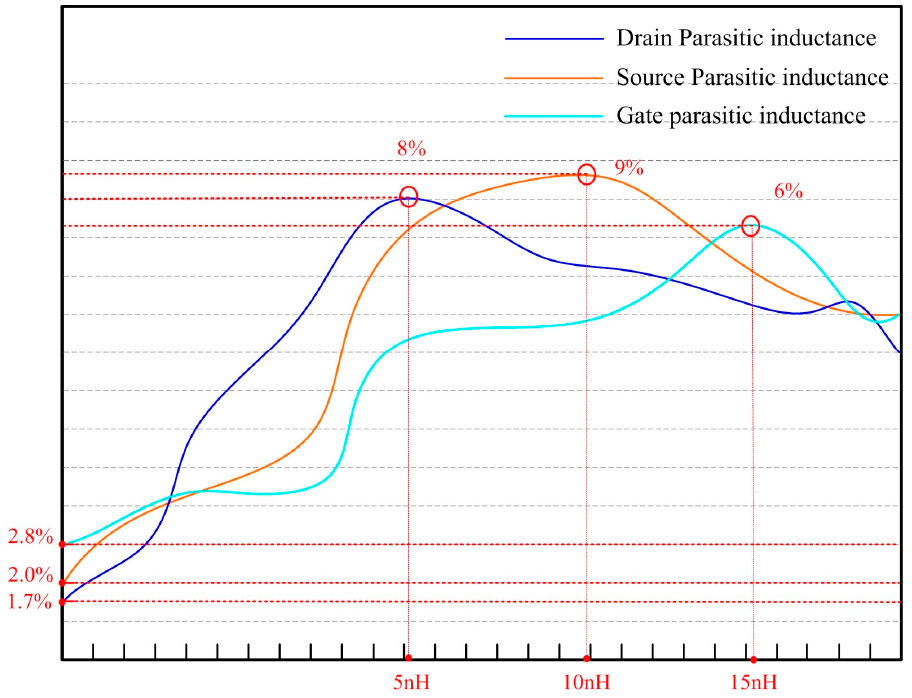
Figure 21. Variation curve of the r Δ i curve on L g /L d /L s . The delay of the forward/reverse driving signal impacts r ∆ i symmetrically, as shown in Figure 22. The interference of other irrelevant signals leading to the existence of fluctuation deviation is shown in the red box of Figure 22. The r ∆ i reaches the maximum/minimum values of 5% and − 5.3% when the forward and reverse driving signals are delayed by 10 ns. The average values of r ∆ i on the forward and reverse driving signals are approximately 3.0% and − 3.2% because of the existence of irrelevant signal interference. The average value of r ∆ i is approximately equal to the average value of r ∆ i on the reverse driving signal on the forward driving signal, assuming that the interference of irrelevant signals is excluded. The forward/reverse driving signals affect the parallel current-sharing imbalance similarly, while the direction is